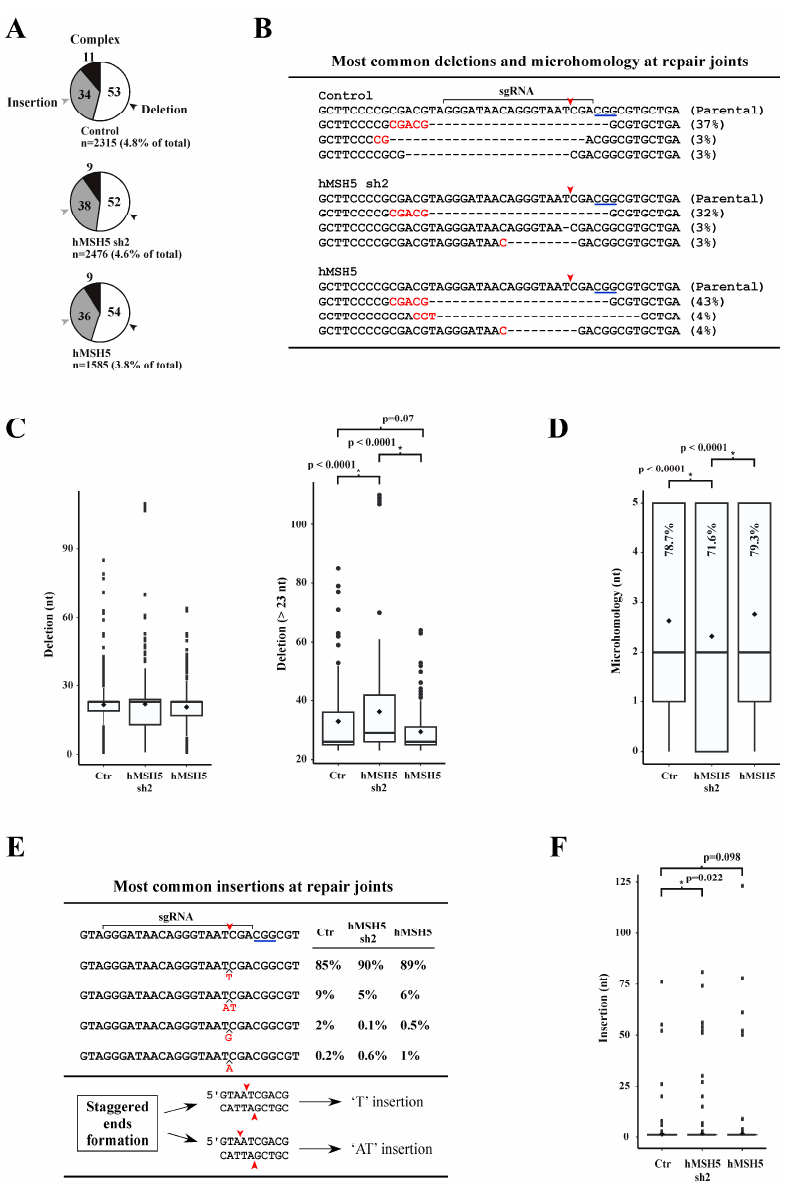
Figure 2. Hi-throughput sequence analysis of DSB repair junctions at the chromosomal NHEJ#8-1 1 locus. ( A ) Pie charts illustrate the divisions of sequence reads. Numbers inside the pie charts represent the percentages of each class of repair joints. ( B ) Sequence alignment of the most common deletions at repair joints. The occurrence of corresponding deletions is indicated by percentage. Red arrowheads mark the cleavage position by CRISPR/Cas9, and MHs are highlighted in red. ( C ) Box-and-whisker plot analysis of the length of deletion at repair joints. Height of the box is defined by the lower and upper quartiles, in which the thick line inside the box represents the median while the diamond represents the mean. Dots are values 1.5 times lesser or greater than the interquartile range. All sequences of 23-nt deletion but devoid of the 5-nt MH were included in the analyses. ( D ) Box-and- whisker plot analysis of MH length at repair joints. Percentages of junction sequences possessing MH are indicated for each category. ( E ) Compilation of the most common insertions at the repair joints. Inserted nucleotides are highlighted in red with their frequencies provided for each hMSH5 category. ( F ) Box-and-whisker plot analysis of insertion length at the repair joints. The Mann–Whitney U-test was used for statistical analysis, and p values were provided for those with statistical significance (in a few cases, non-significant p values were also provided for